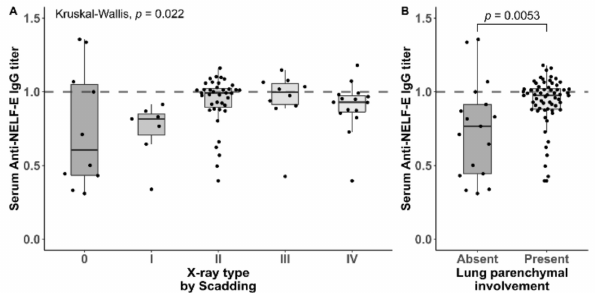
Figure 4. ( A ) Titers of Immunoglobuline G-antibodies against the Negative Elongation Factor E across X-ray types by Scadding scale in patients with sarcoidosis ( n = 82). ( B ) Titers of IgG-antibodies against the NELF-E depending on lung parenchymal involvement in patients with sarcoidosis ( n = 82). The titer is considered positive, if it is the same or higher than the cut-o ff